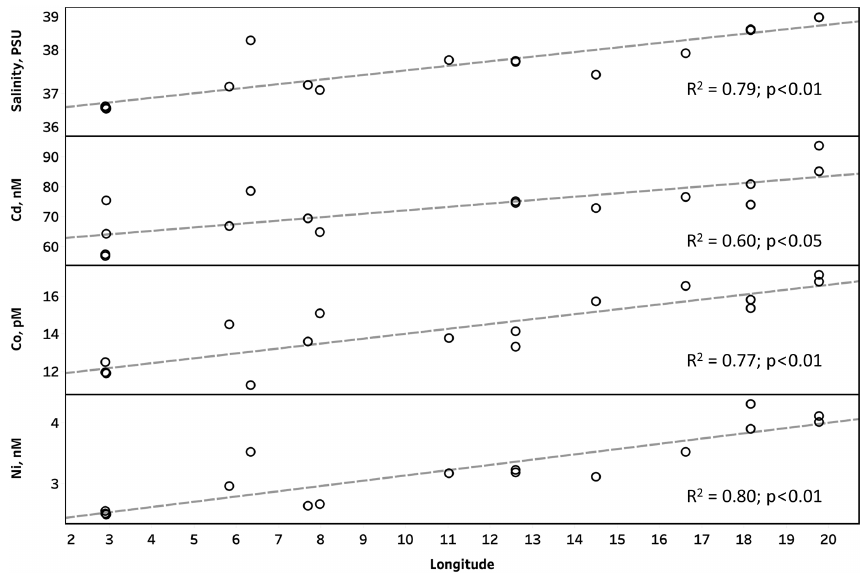
Figure 3. Salinity and concentration of dissolved trace metals in subsurface waters (SSW) plotted against longitude. The dashed lines represent least-square linear